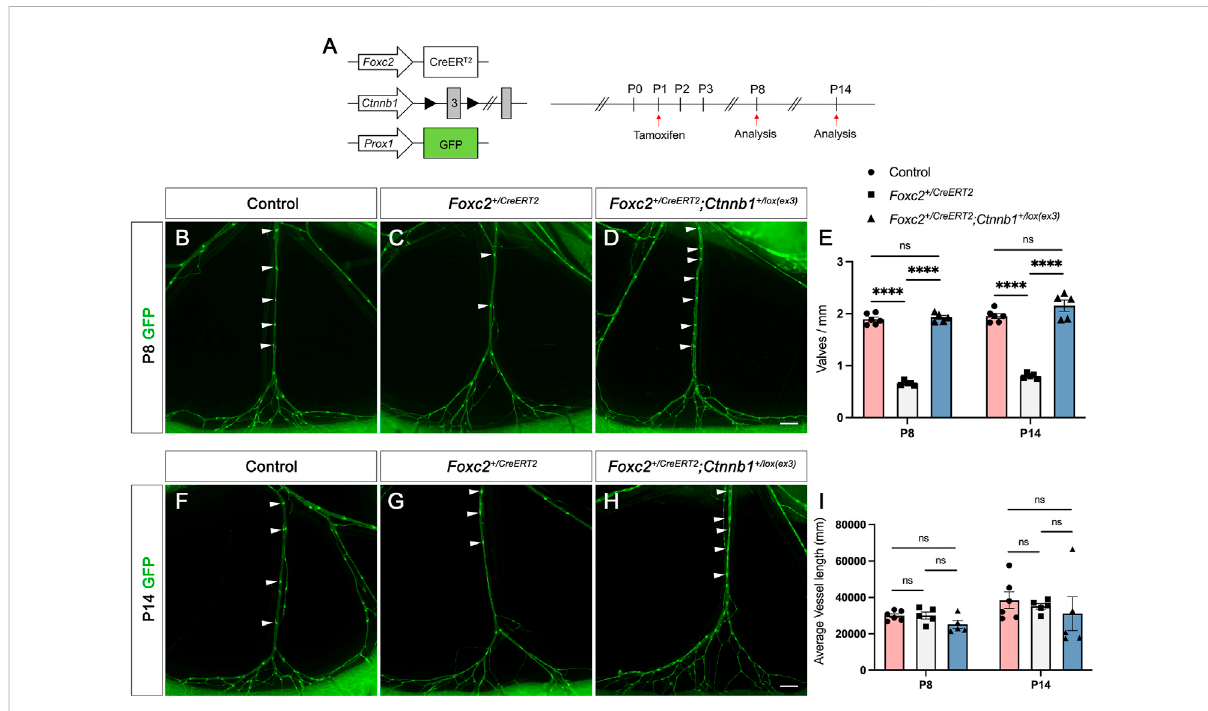
FIGURE 5 Overactivation of β -catenin in the nucleus rescues valve loss in Foxc2 +/CreERT2 mice. (A) Schematic illustration of tamoxifen injection procedure that results in deletion of exon 3 of Ctnnb1 via CreER T2 activation. (B – D) Fluorescent images show the morphology of mesenteric collecting lymphatic vessels at postnatal day (P) 8. (E) Quanti fi cation of valves per millimeter at P8 and P14. (F – H) Fluorescent images show the morphology of mesentericcollectinglymphaticvesselsatP14. (I) Quanti fi cationofvessellengthatP8andP14.Whitearrowheadspointtovalvesdeterminedby highGFP(green)expression.Sixcontrol, fi ve Foxc2 +/CreERT2 ,and fi ve Foxc2 +/creERT2 ; Ctnnb1 +/ fl ox(exo3 ) mesenteriesareusedfortheanalysis.Allvaluesare mean ± SEM. One-way ANOVA was performed with Tukey ’ s multiple-comparison test for P8 and P14, respectively. ns = not signi fi cant, **** p < 0.0001. Scale bars are 500 µM (B,C,D,F,G,H)